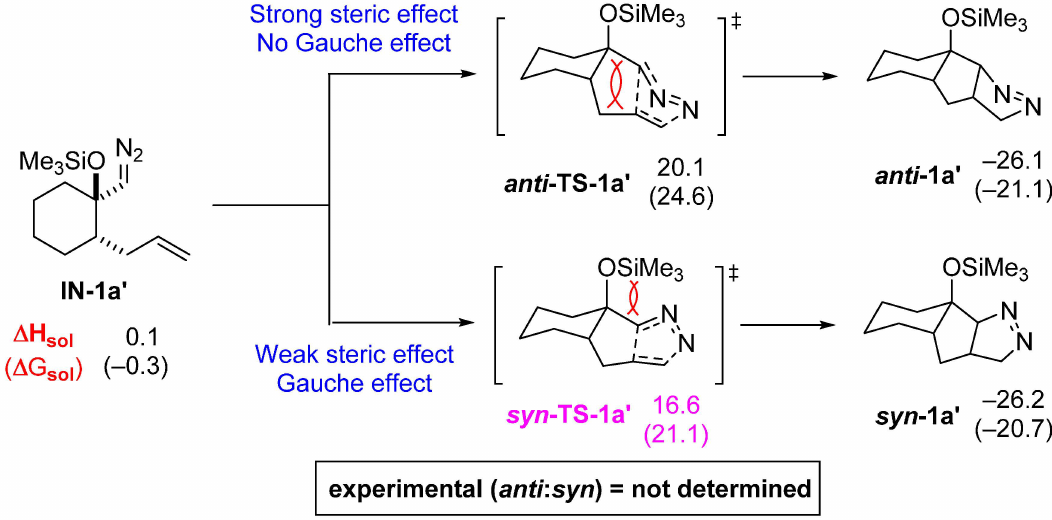
Figure 5. Energy profiles of pyrazoline formation with high syn -diastereoselectivity (in kcal/mol).